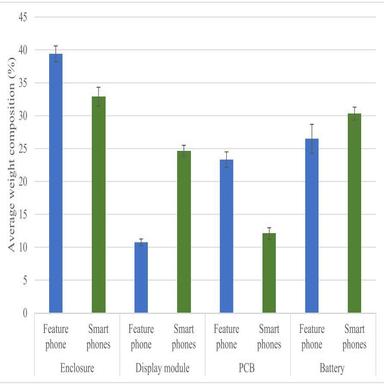
Average weight percentage composition of mobile phones.